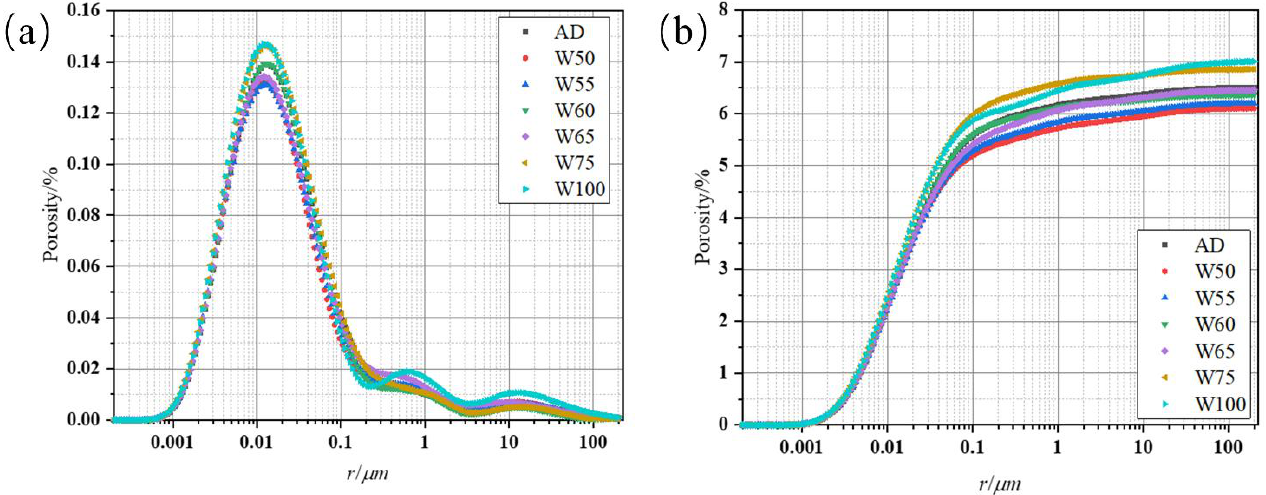
Figure 11. Water adsorption coefficient of recycled concrete.